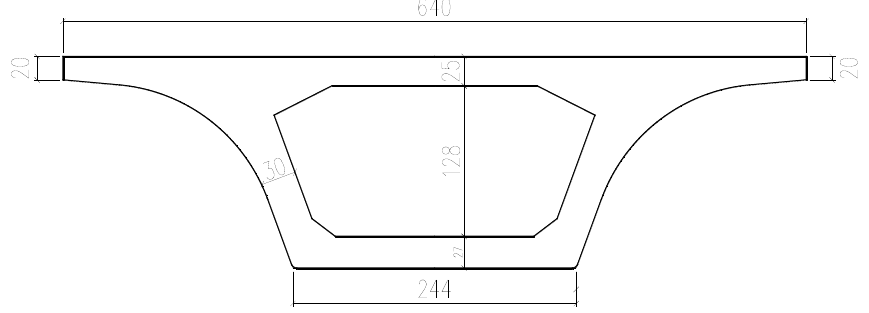
Figure 5. Box girder section (Unit: cm).